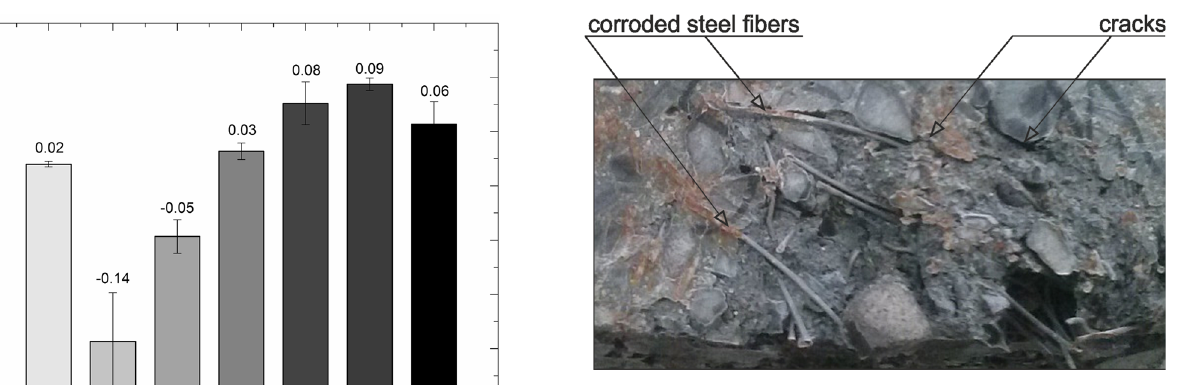
Fig. 8 Failure mode of concrete sample with 1% SF content after freeze–thaw resistance test.